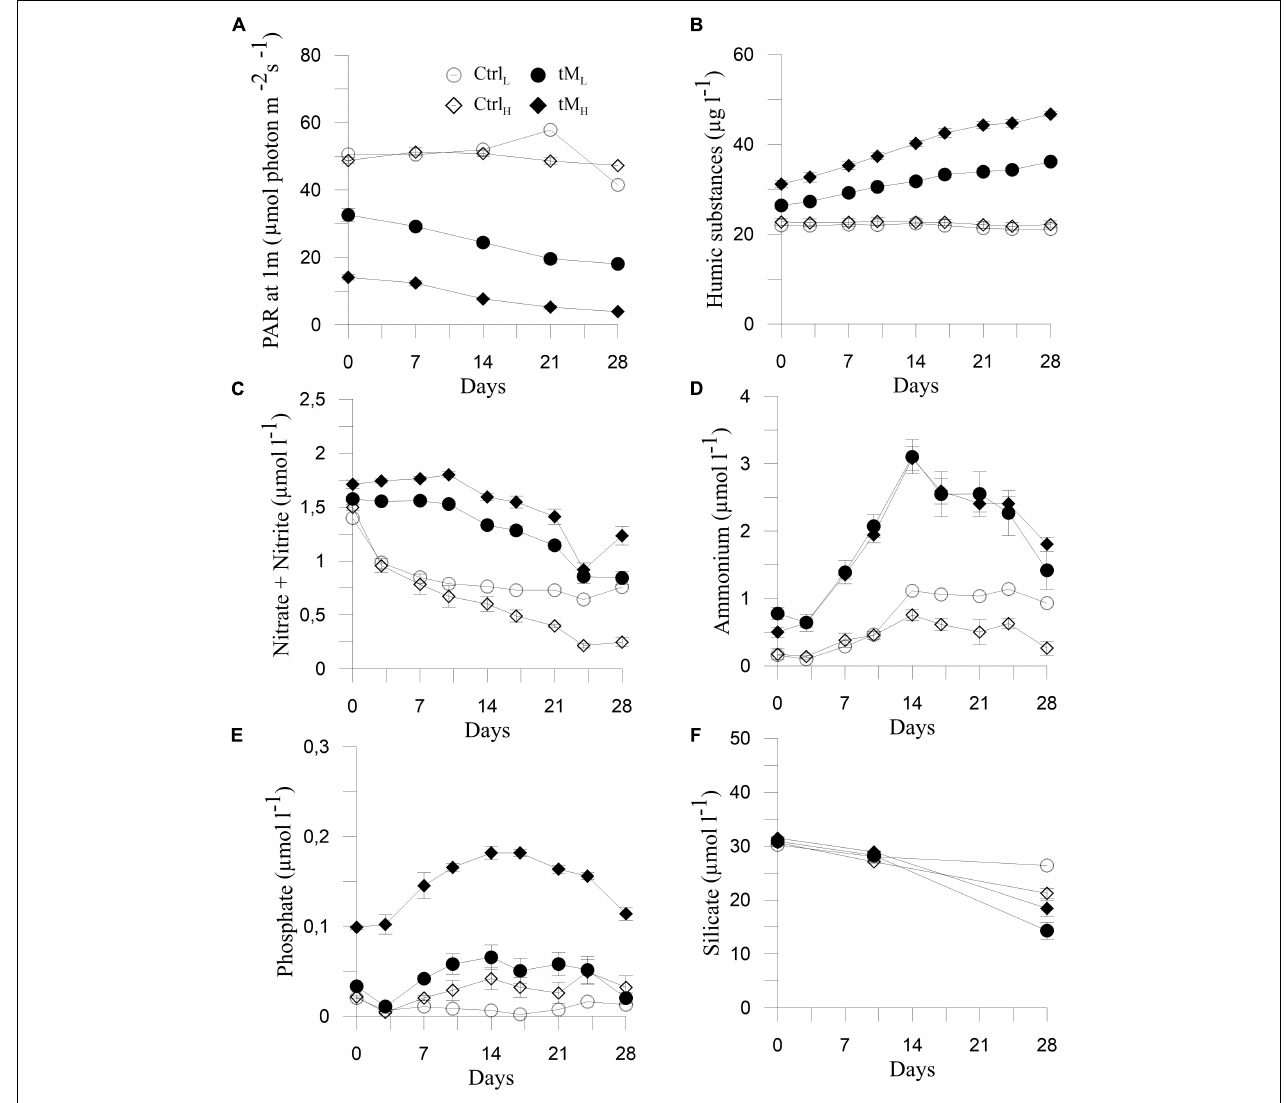
FIGURE 1 | Temporal variation of physicochemical factors during the experiment: Photosynthetic Active Radiation (PAR) at 1 m (A) modified after Traving et al. (2017), humic substances (B) , nitrate + nitrite (C) , ammonium (D) , phosphate (E) , and silicate (F) . Means ± standard error, n =